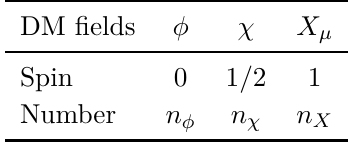
Table 1 . DM fields: φ is a real scalar field, χ is a right-handed fermion, and X µ is a vector field. The DM fields are assumed to be singlets under the SM gauge group, so all DM fields are electrically